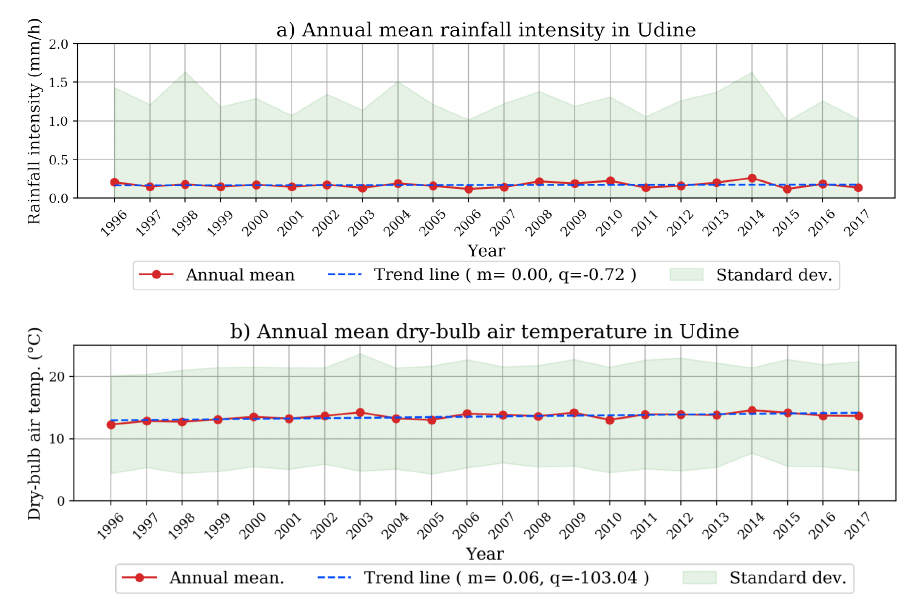
Figure 2. Annual mean rainfall intensity ( a ) and annual mean dry-bulb air temperature ( b ) in Udine, linear trend and standard deviation calculated on the hourly values.